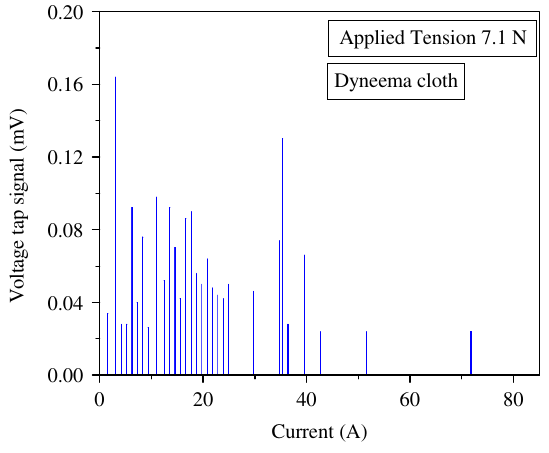
FIG. 4. (Color) Voltage tap signal as a function of current.